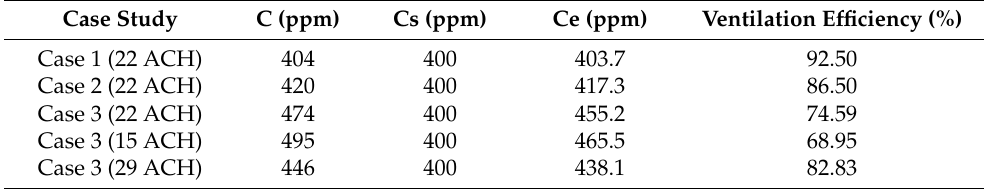
Table 3. Ventilation efficiency